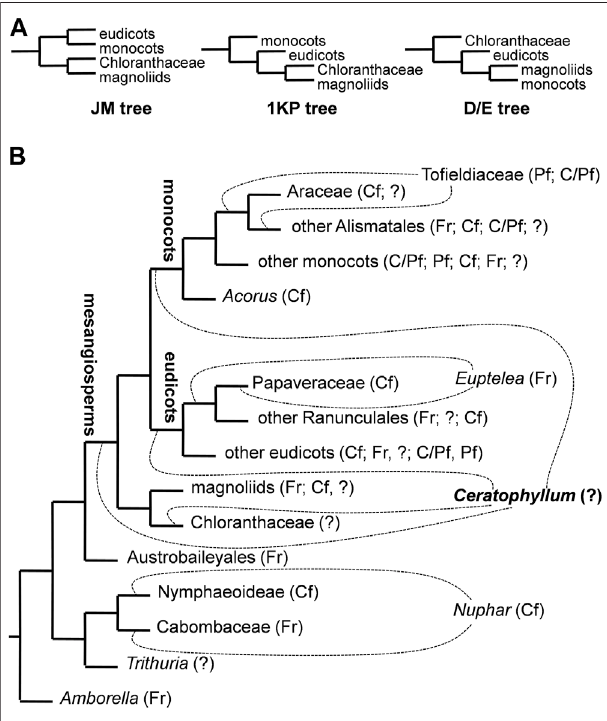
FIGURE 2 | Ambiguities among various phylogenetic trees of angiospermsconsidered inthepresentstudy. (A) Simpli fi eddiagramsofthree major hypotheses of relationships among clades of mesangiosperms with the position of Ceratophyllum omitted. See text for details on naming these topologies. (B) simpli fi ed ‘ main ’ tree topology (JM tree) explored in an important recent study of character evolution in angiosperms (Sauquet et al., 2017). Dotted lines indicate contrasting positions for Ceratophyllum and three other problematic taxa. Abbreviations after taxon names indicate types of fusion between carpels in a rough sequence of their frequency/closeness to the root in each terminal group: Fr, carpels free; Cf, congenital fusion: Pf, postgenital fusion: C/Pf, both types of fusion in the same gynoecium: ? gynoecium monomerous or reportedly monomerous and thus the fusion character is apparently not